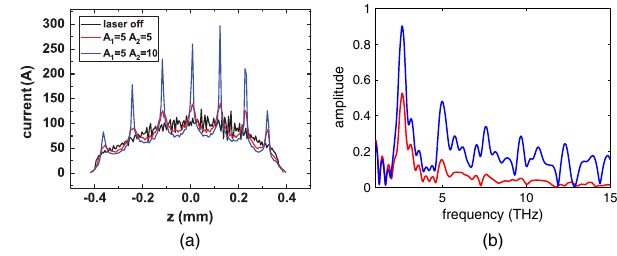
FIG. 9. Beam current and its fast-Fourier-transform image. (a) Beam currents for A 2 ¼ 5 (red) and A 2 ¼ 10 (blue) when A 1 ¼ 5 and initial current without laser modulation (black). (b) FFT image of beam current for A 2 ¼ 5 (red) and A 2 ¼ 10 (blue) when A 1 ¼ 5